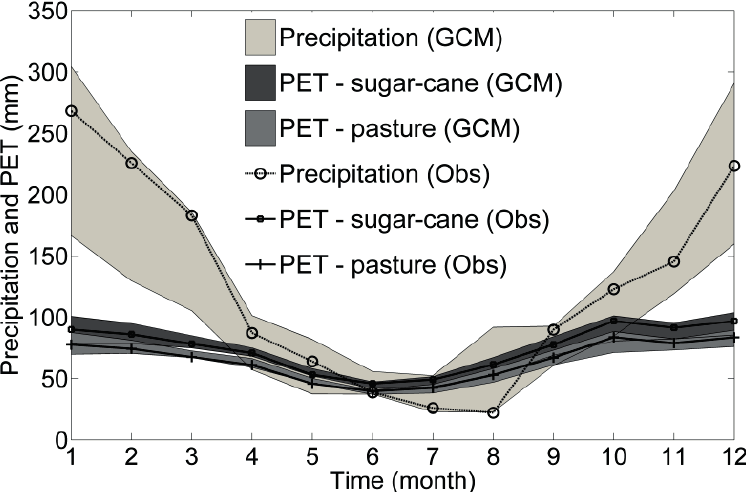
Fig. 1 Monthly averaged precipitation and PET variation range for years